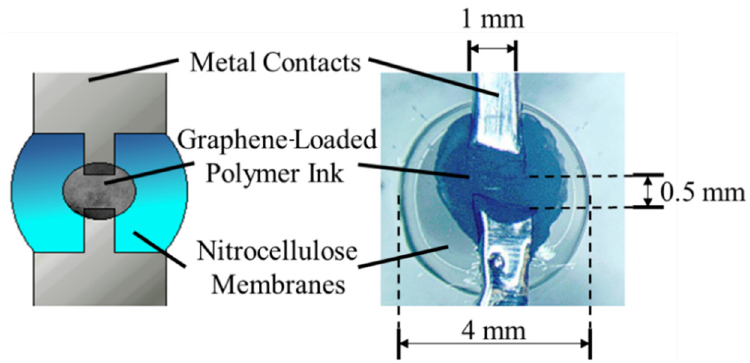
Figure 2. Graphene-loaded polymer filament structure.